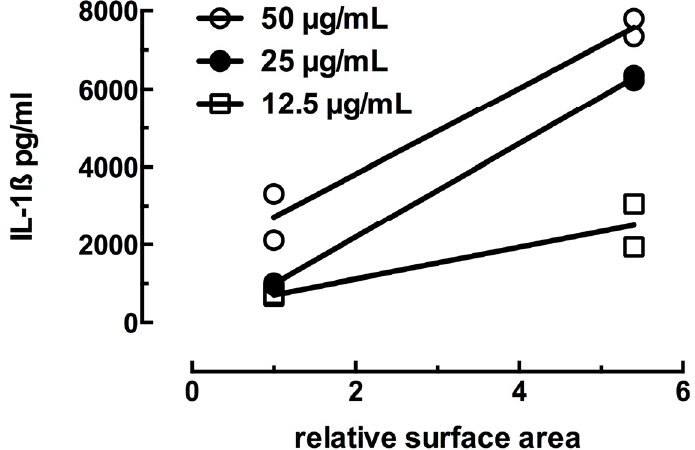
5.48 = 20 nm), and IL-1 β production by THP-1 cells. Significant regression plots at two highest concentrations.